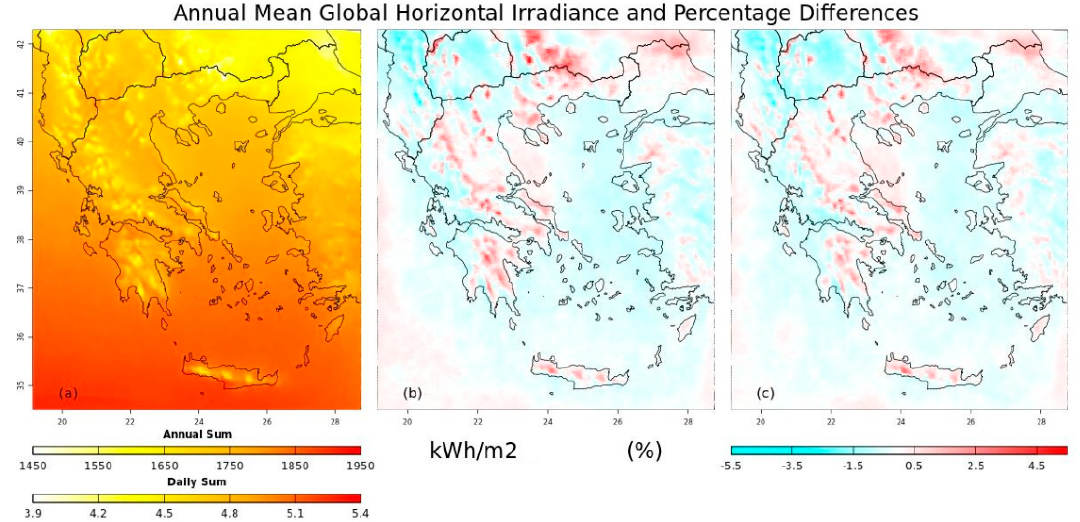
Figure 5. Mean annual GHI values at historic period ( a ) and percentage differences with ( b ) Representative Concentration Pathway (RCP) 4.5 and ( c ) RCP8.5 scenarios.